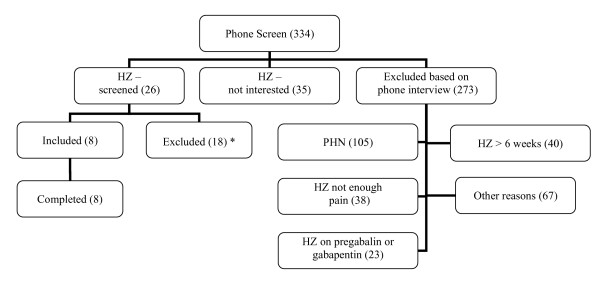
CONSORT Statement. * Screened subjects excluded before randomization due to: not enough pain (1), BMI < 20 (1), creatinine clearance <60 ml/min (2), significant medical or psychiatric illness (4), medication (1), unclear diagnosis (1), withdrew consent (8).